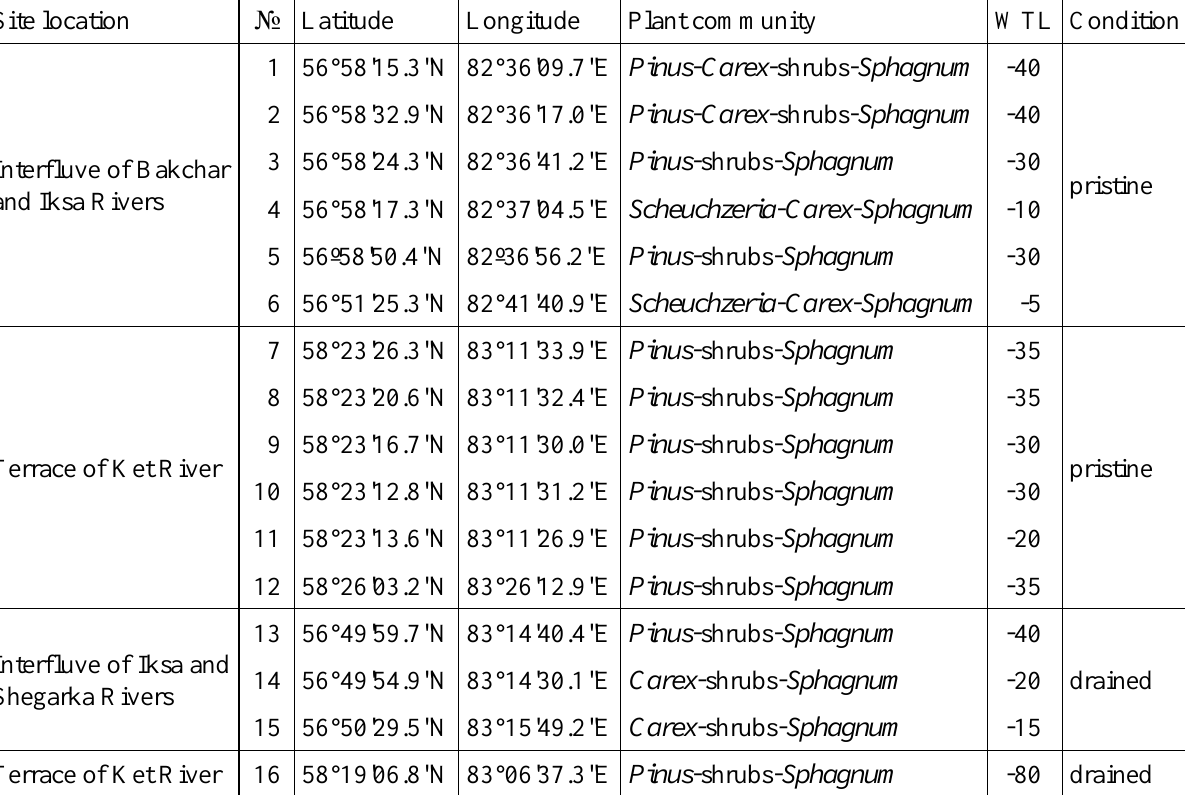
Table 1. Locations and characteristics of the studied bogs. WTL = depth of water table below surface in cm. Site